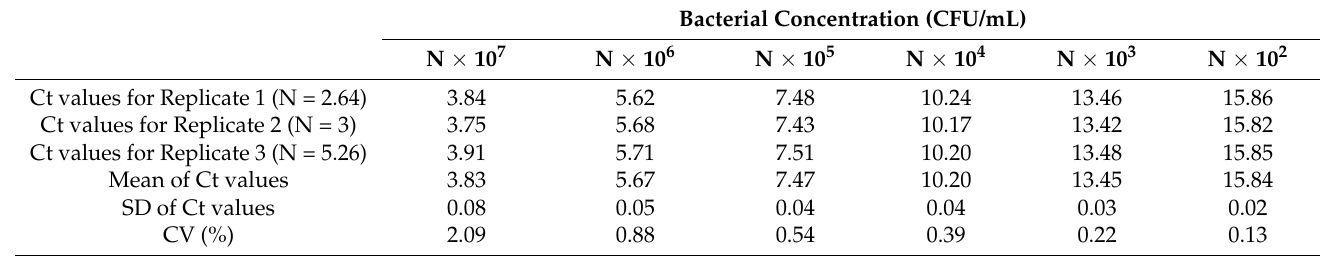
Table 2. CV values and Ct values of different